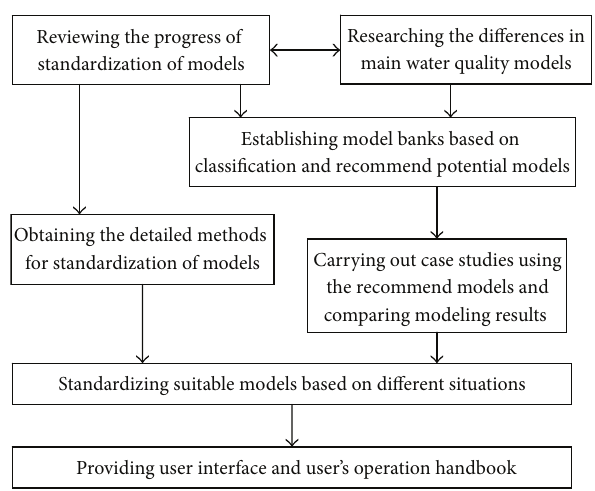
Figure 1: Flow chart of the standardization of water quality models.